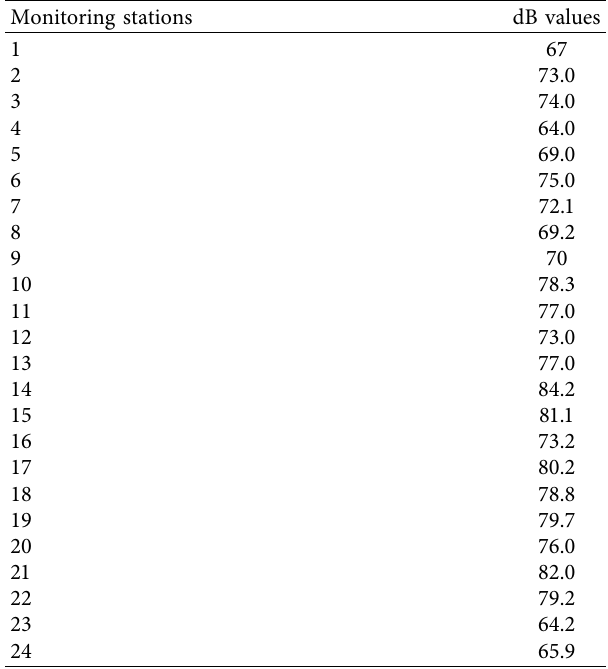
Table 1: Daytime average decibel values.